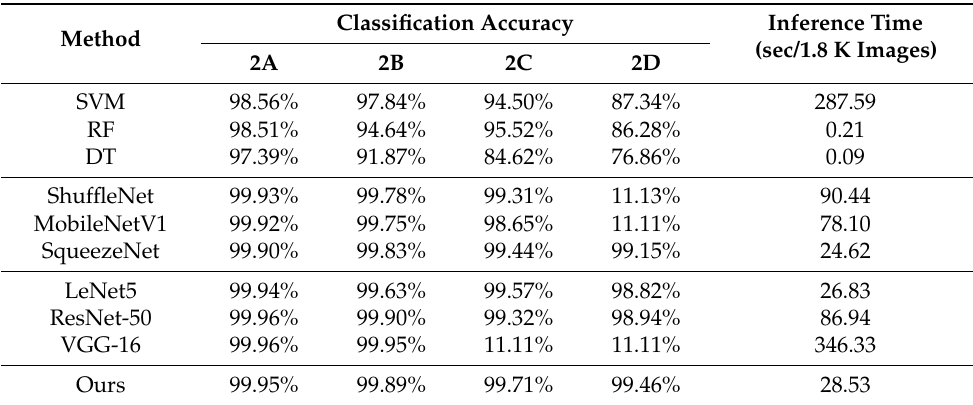
Table 10. Table 10. The comparison results of different methods and the proposed